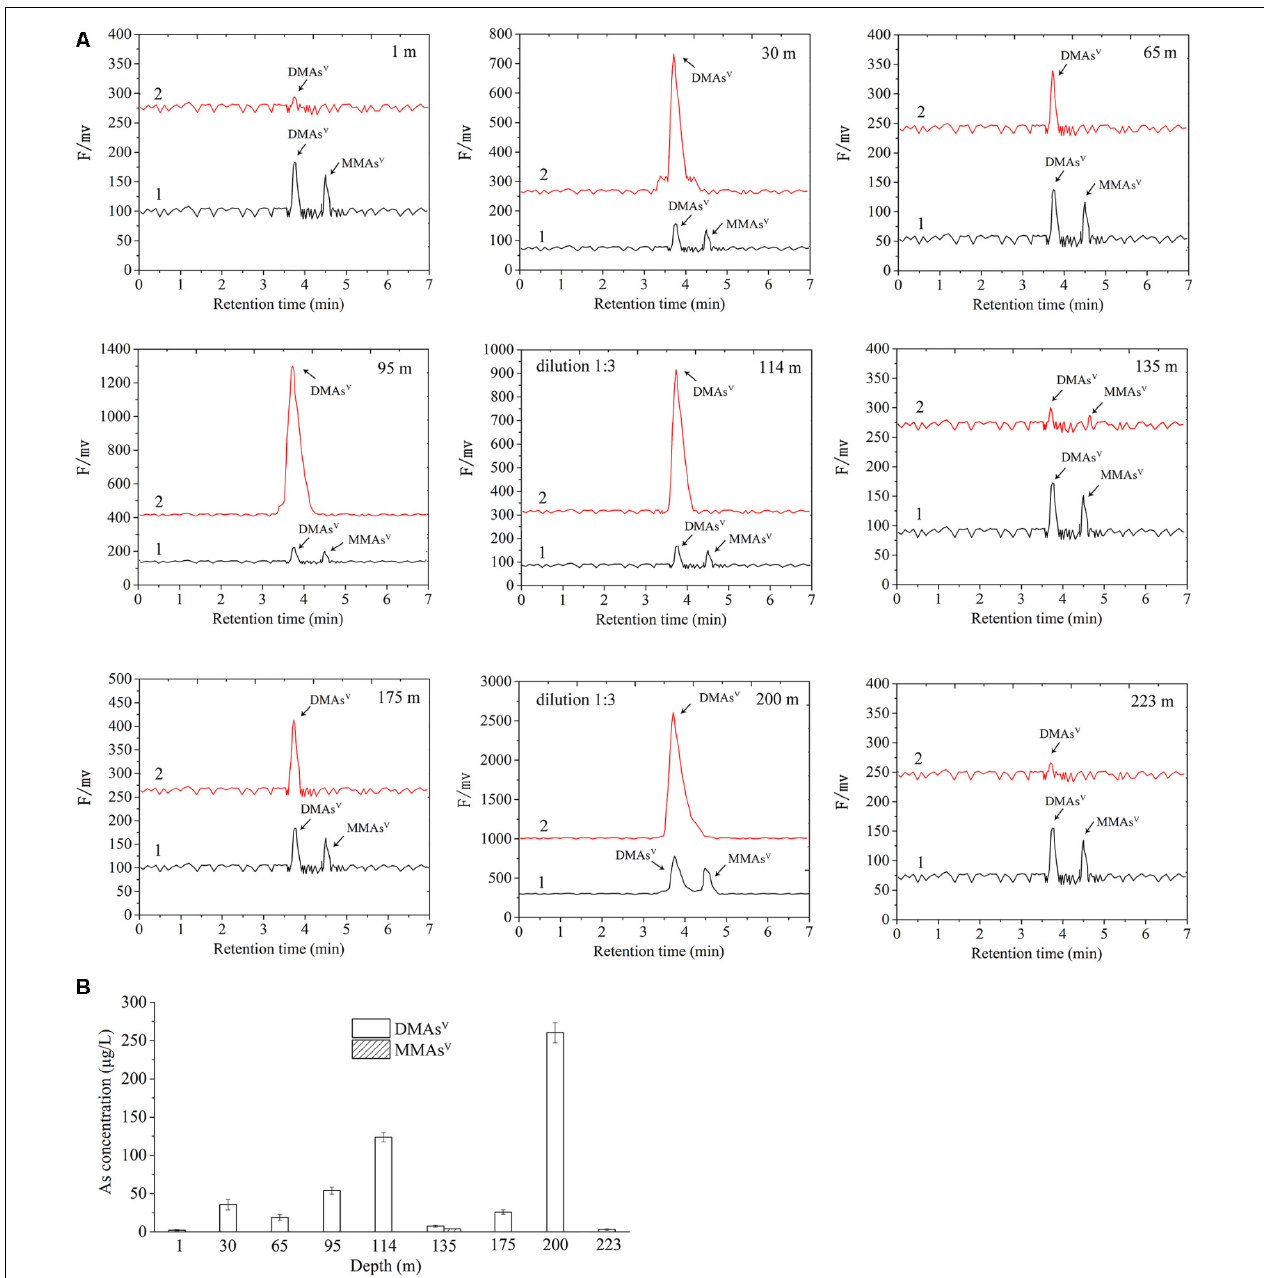
FIGURE 2 | Arsenic methylation activities of the microbial communities of the nine samples collected from the arsenic-rich shallow and deep sediments in Jianghan Plain. (A) HPLC-ICP-MS chromatograms of the methylated As species produced by the microbial communities of the samples from 1 to 223 m after 80.0 days of incubation. Curve 1, standards of DMAs V and MMAs V ; curve 2, DMAs V and MMAs V concentrations in the microcosms amended with 0.23 mM As(III) as the substrates of ArsM enzymes, and 20.0 mM lactate as the carbon source after 80.0 days of incubation. (B) Concentrations of the methylated As in the microcosms of the samples from 1 to 223 m after 80.0 days of